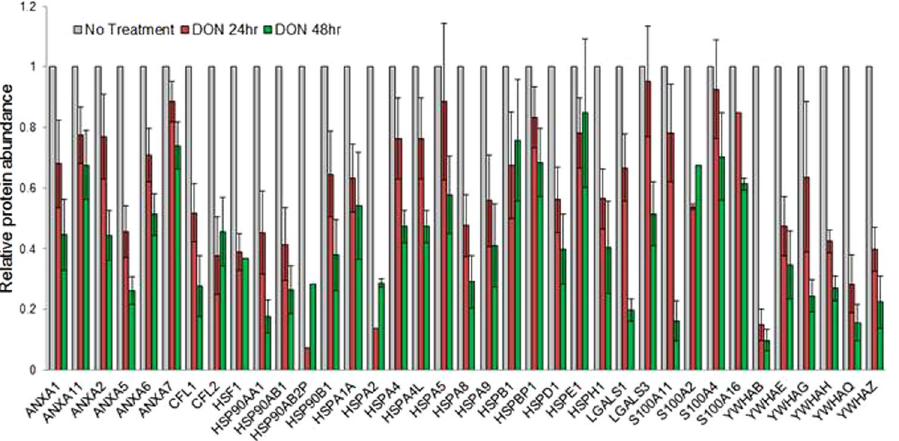
Figure 7. Abundance change of proteins previously associated with chemoresistance of pancreatic cancer, including annexin family, 14-3-3 protein family, cofilins, galectins, S100 proteins and a number of heat shock proteins. The error bars represent